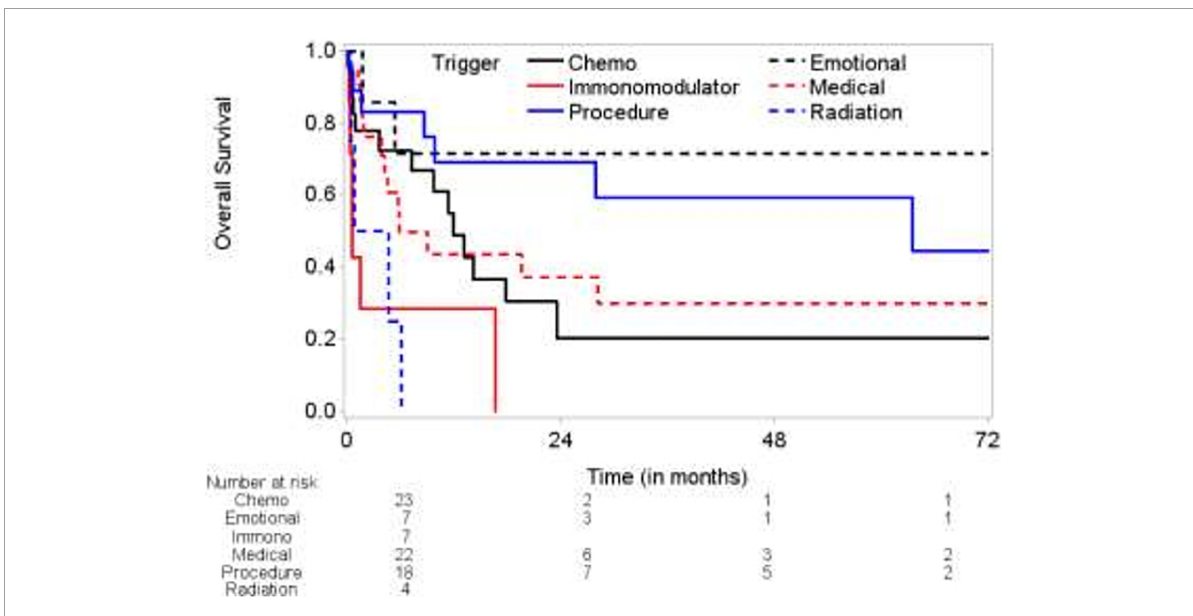
FIGURE2 Kaplan-Meier curves for survival based on individual